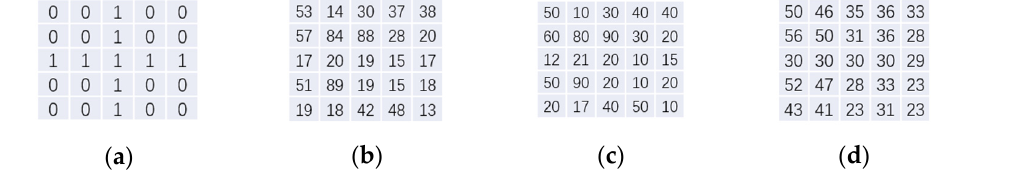
Figure 3. The matrix of examples: ( a ) template; ( b ) target; ( c ) bilateral filter; and ( d ) joint bilateral filter.